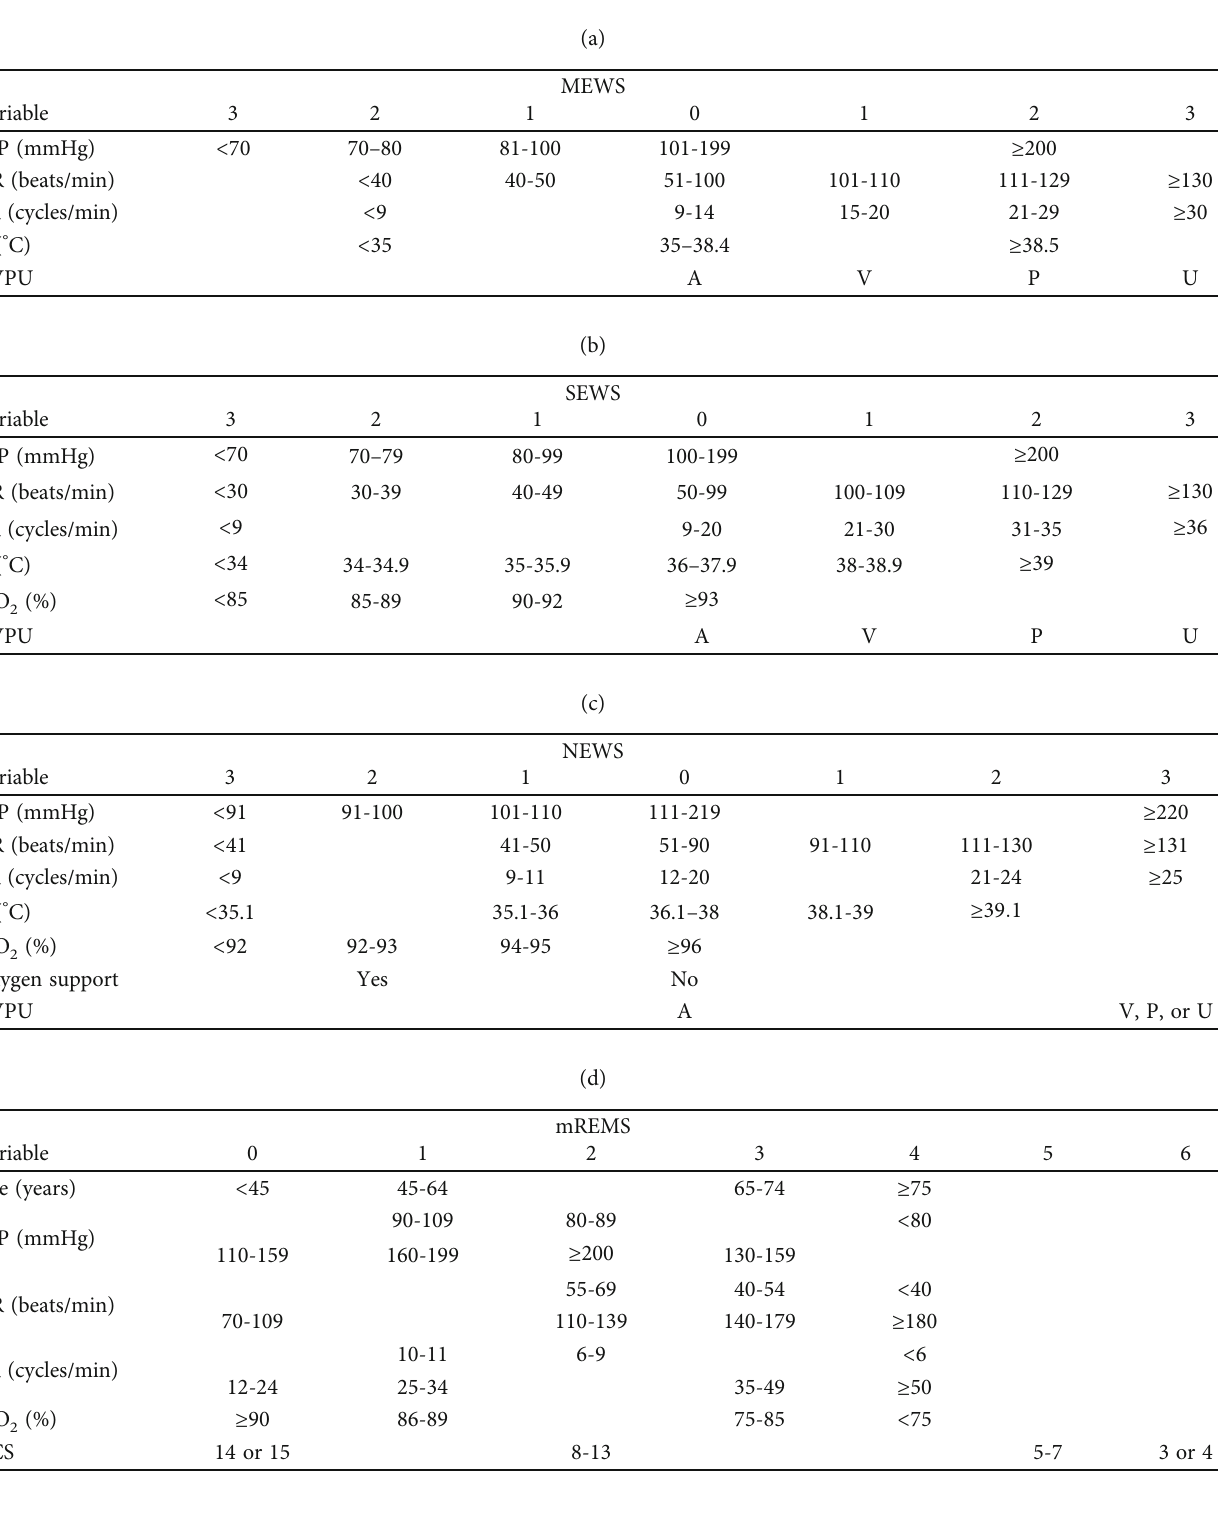
Table 1: Five trauma triage